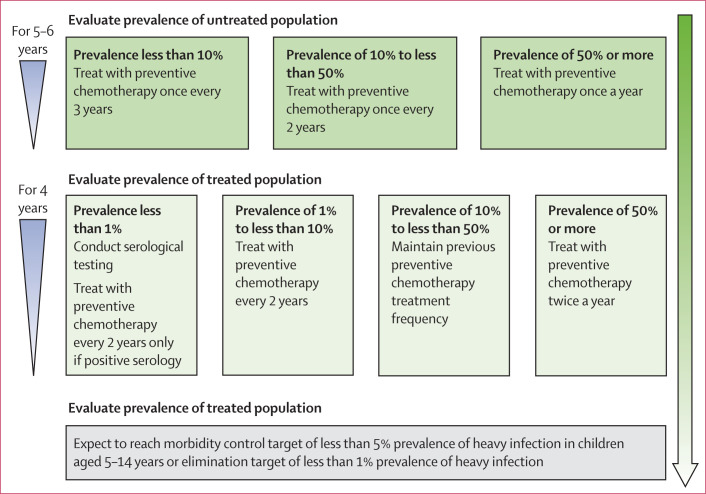
Standard WHO strategy for drug-treatment-based schistosomiasis controlTreatment is targeted to the entire population of children aged 5–14 years, but to limit adverse reactions, children who are acutely ill are excluded. Coverage levels are estimated after each cycle of treatment.12